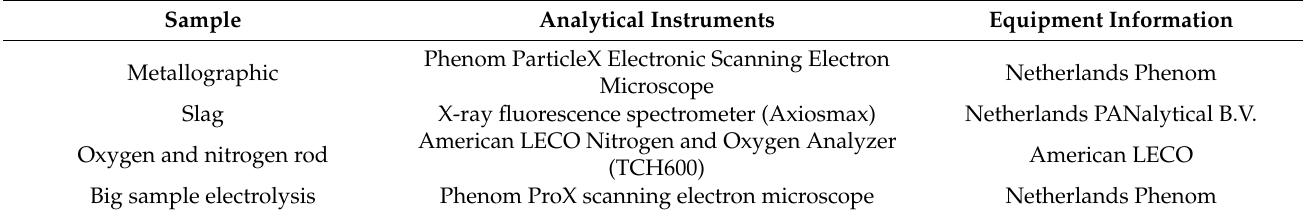
Table 2. Sample analysis